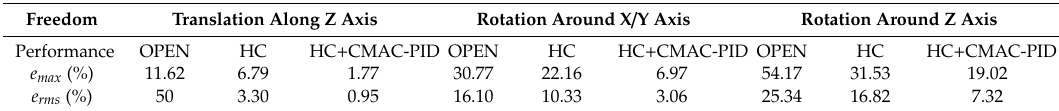
Table 4. Experimental controller performance for the remaining degrees of